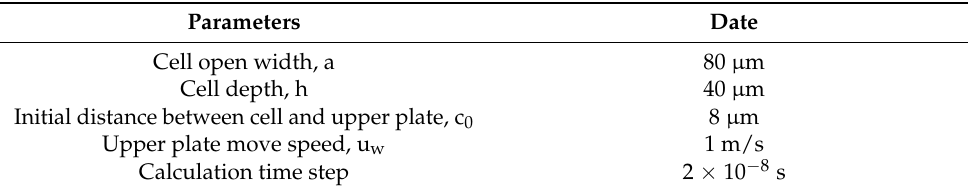
Table 2. Cell geometry